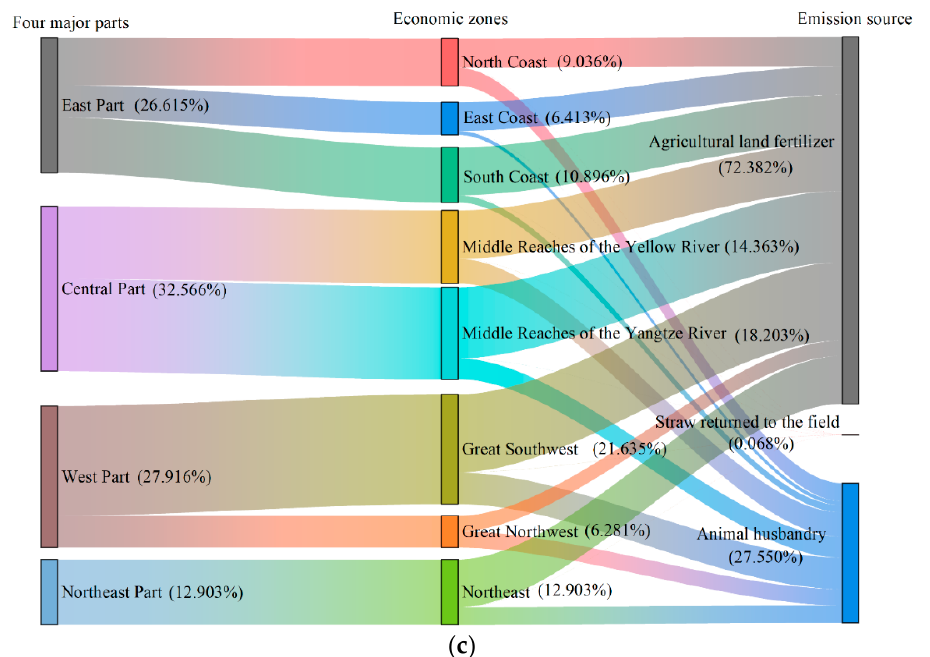
Figure 4. Agriculture-induced N 2 O emissions of economic zones from 2000 to 2019 in China (( a ) 2000; ( b ) 2010; ( c ) 2019).